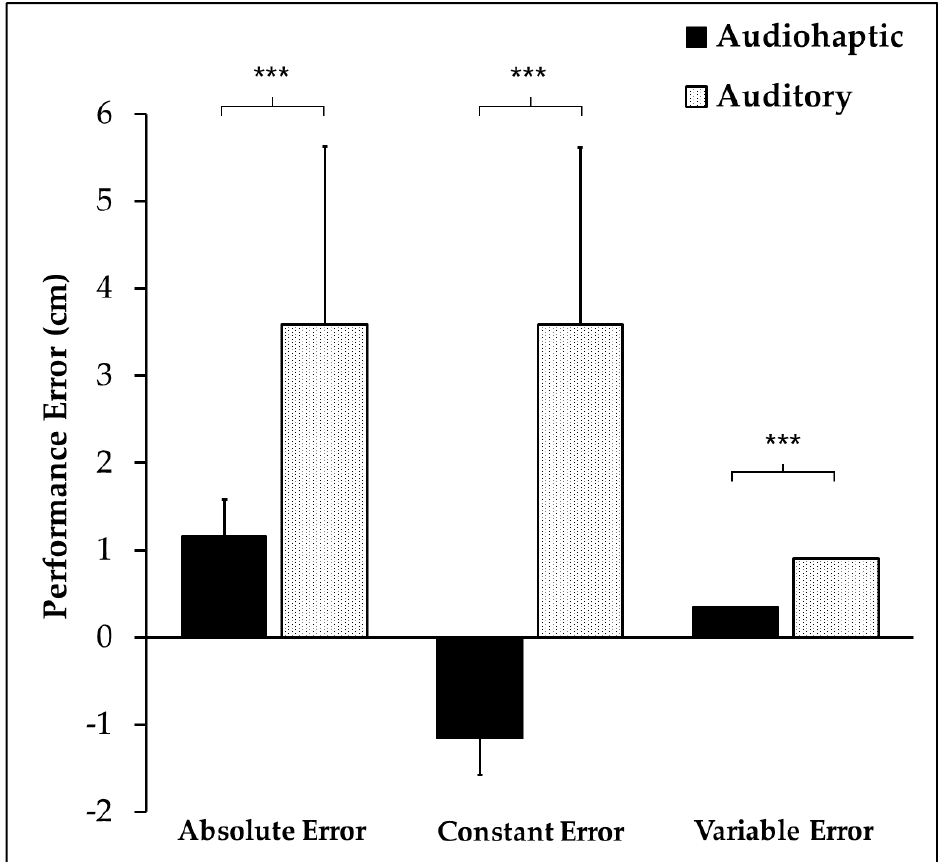
Figure 4. Mean and standard deviation (error bars) of performance errors in both trial types. Statistical results are noted as *** p <